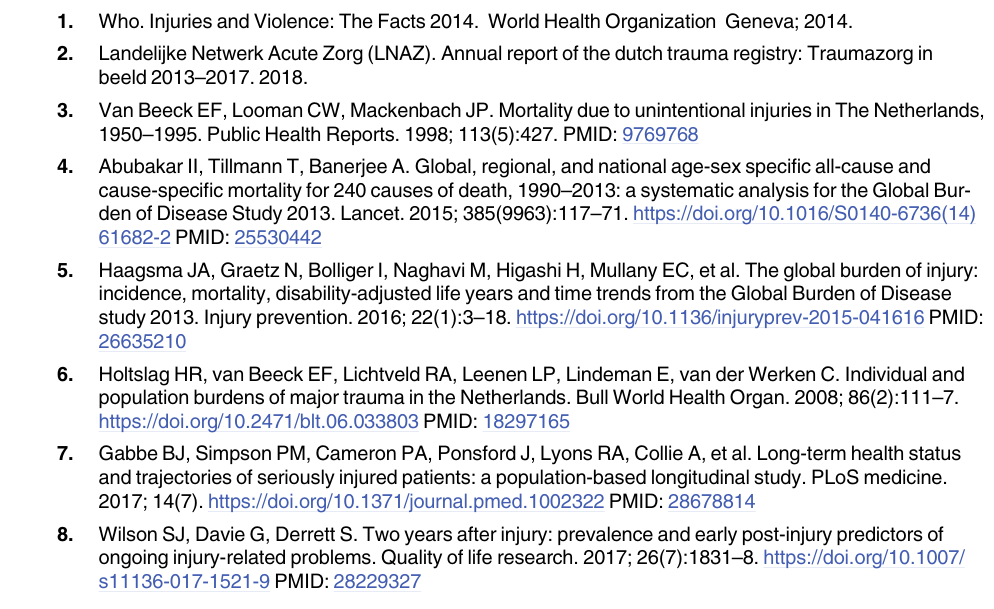
S1 Table. Unit costs (2017 € ). S2 Table. Mean and median health care costs and productivity costs in 2017 euro; includ- ing range and number of